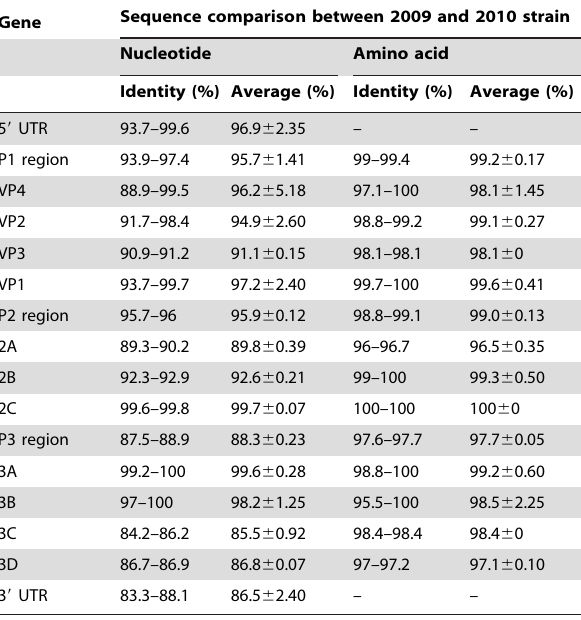
Gene Sequence comparison between 2009 and 2010